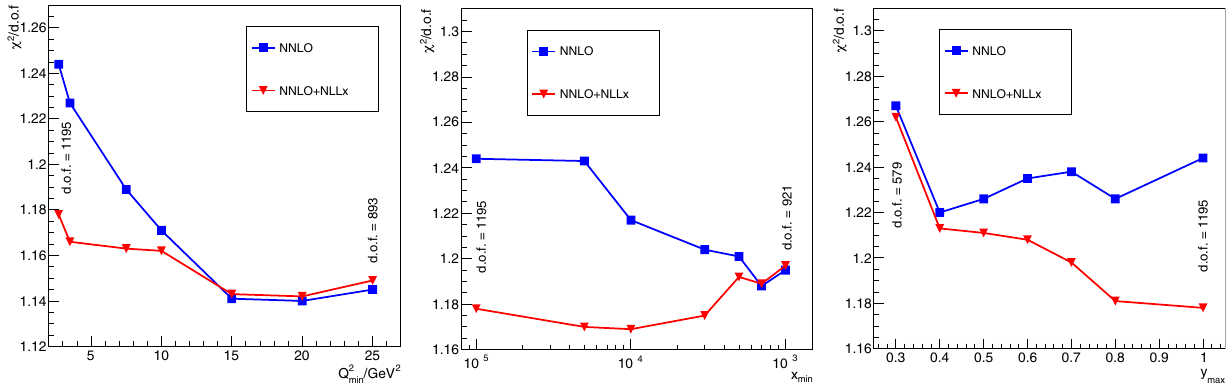
Fig. 11 The χ 2 /d.o.f. as a function of Q 2 (left), x min (center), and y max (right). Each plot reports also the number of degrees of freedom at the min extremities of each profile